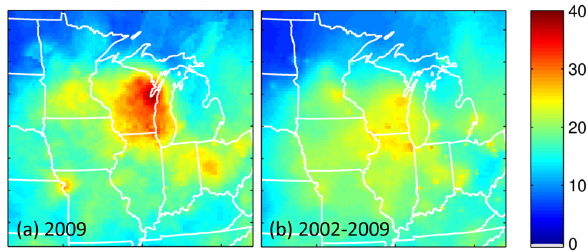
Fig. 12. 5th highest daily PM 2 . 5 concentration during January– March period, using 18km PM 2 . 5 maps kriged from IMPROVE and AQS surface observations. LADCO WNS study period (a) shows higher than normal episodic concentrations in Wisconsin while (b) shows the average of 8yr of 5th high values, and hotspots are most prominent in cities Wisconsin and northern